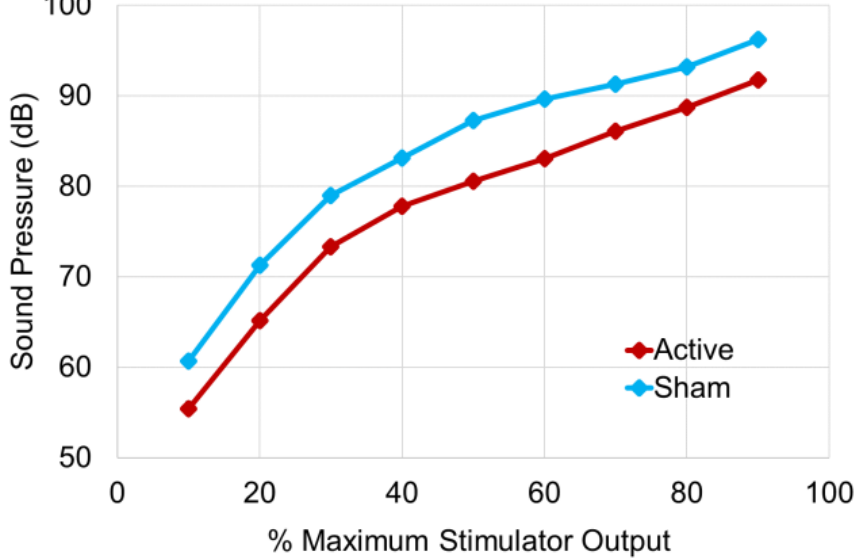
Figure 7. TMS click sound pressure during stimulation in the active and sham coils. The horizontal axis shows the stimulus intensity (MSO) and the vertical axis indicates the sound pressure. MSO was increased from 10% to 90% at 10% intervals, and the sound pressure corresponding to each stimulus intensity was measured for each coil. The red line shows the sound pressure of the click sound in the active coil while the blue line indicates the sound pressure in the sham coil. Each plot shows the average value of five measurements of the maximum value of five single